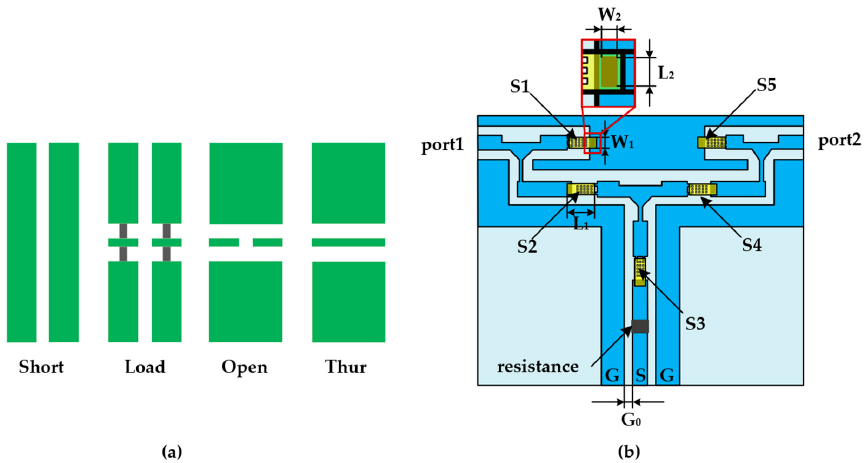
Figure 1. Calibration element structure diagram: ( a ) Discrete calibration unit; ( b ) structure of integrated electronic calibration chip based on RF MEMS switches.